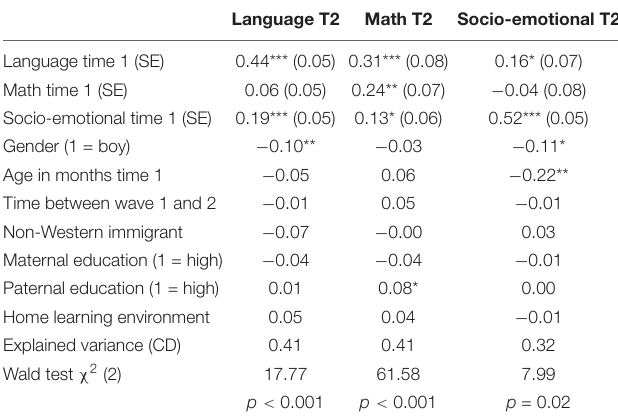
TABLE 3 | Standardized regression coefficients of the autoregressive and cross-lagged paths ( N =